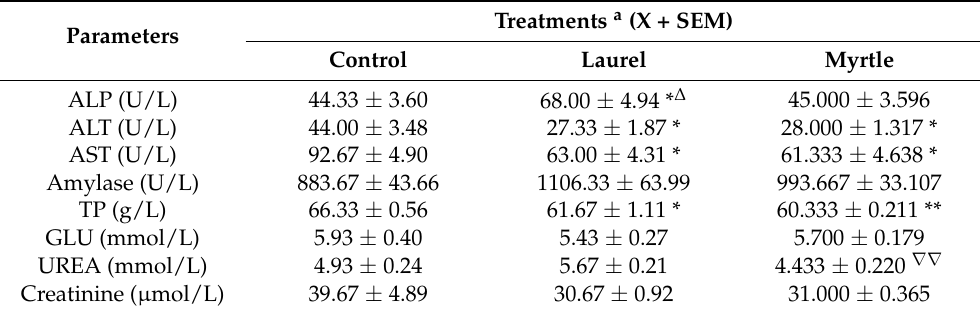
Table 4. Effect of laurel and myrtle EO application on the biochemical parameters in rats.